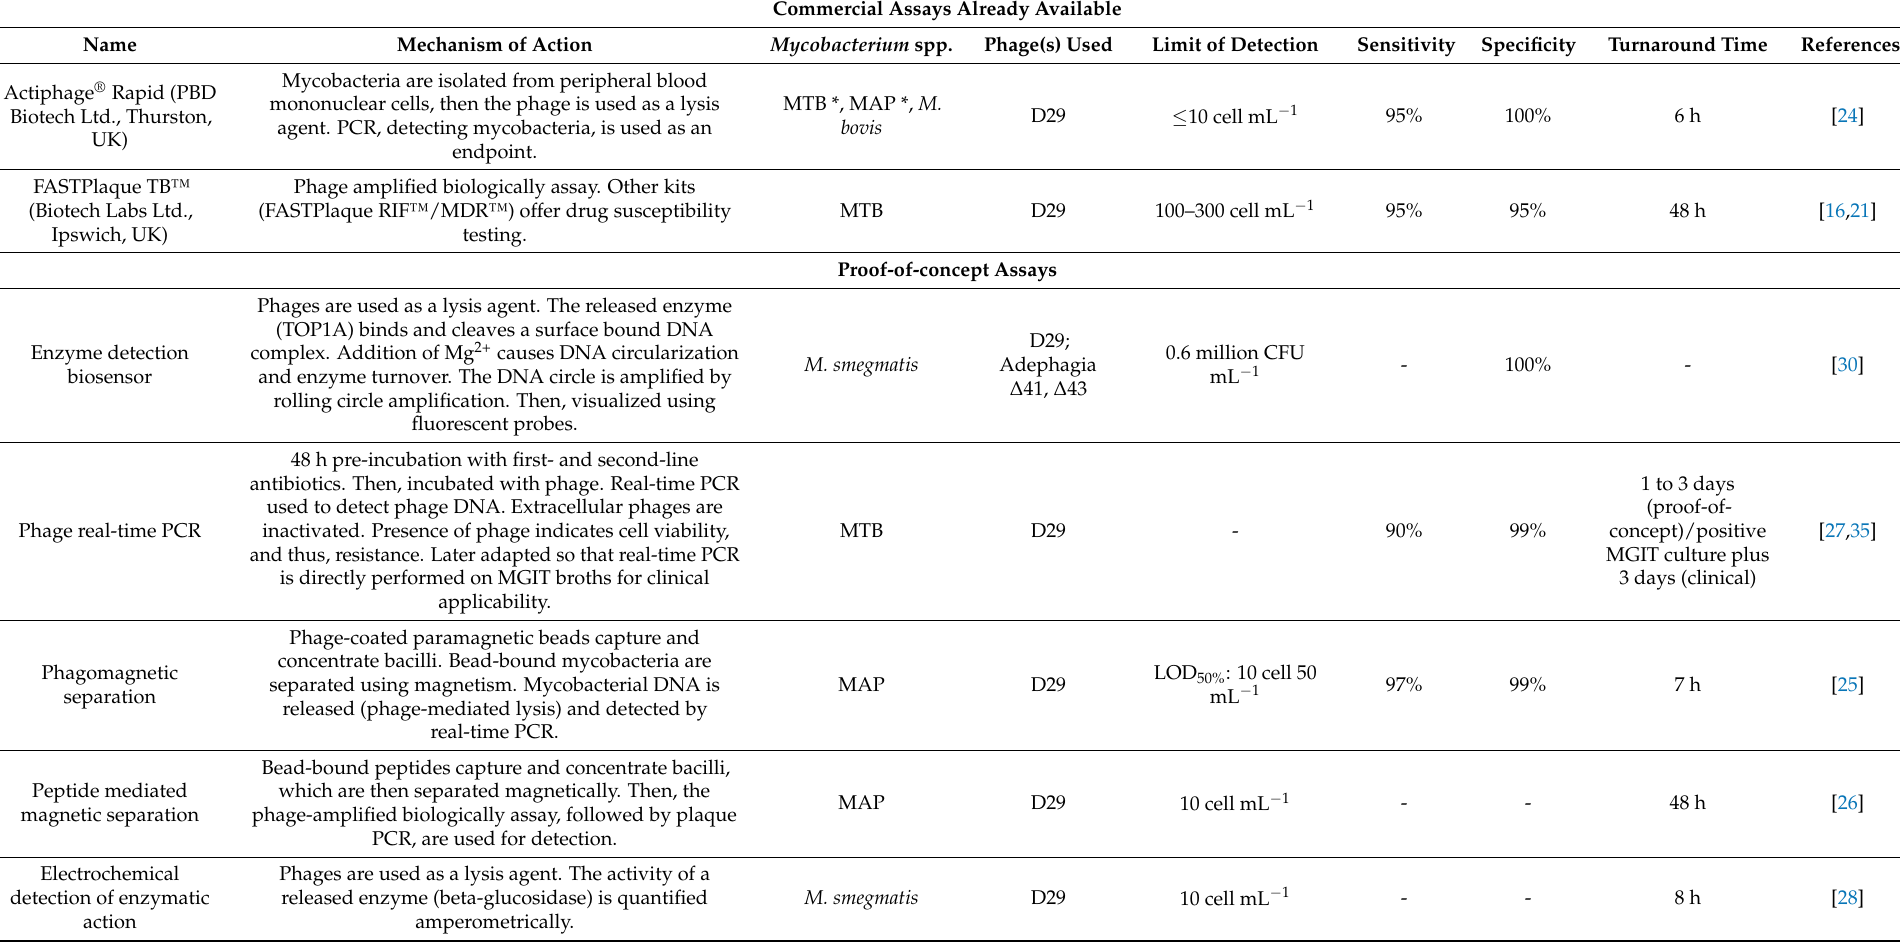
Table 1. Phage technologies used to detect mycobacterial infections. * MTB, M. tuberculosis ; MAP, M. avium subspecies